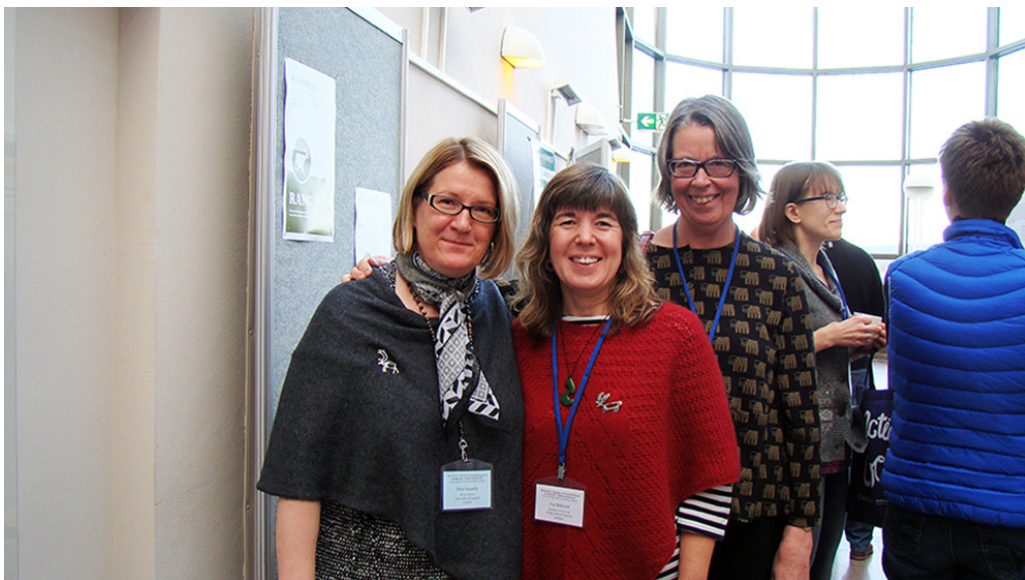
Figure 3. From left to right: Dr. Päivi Soppela, Seminar coordinator; Dr. Eva Wiklund, Editor of